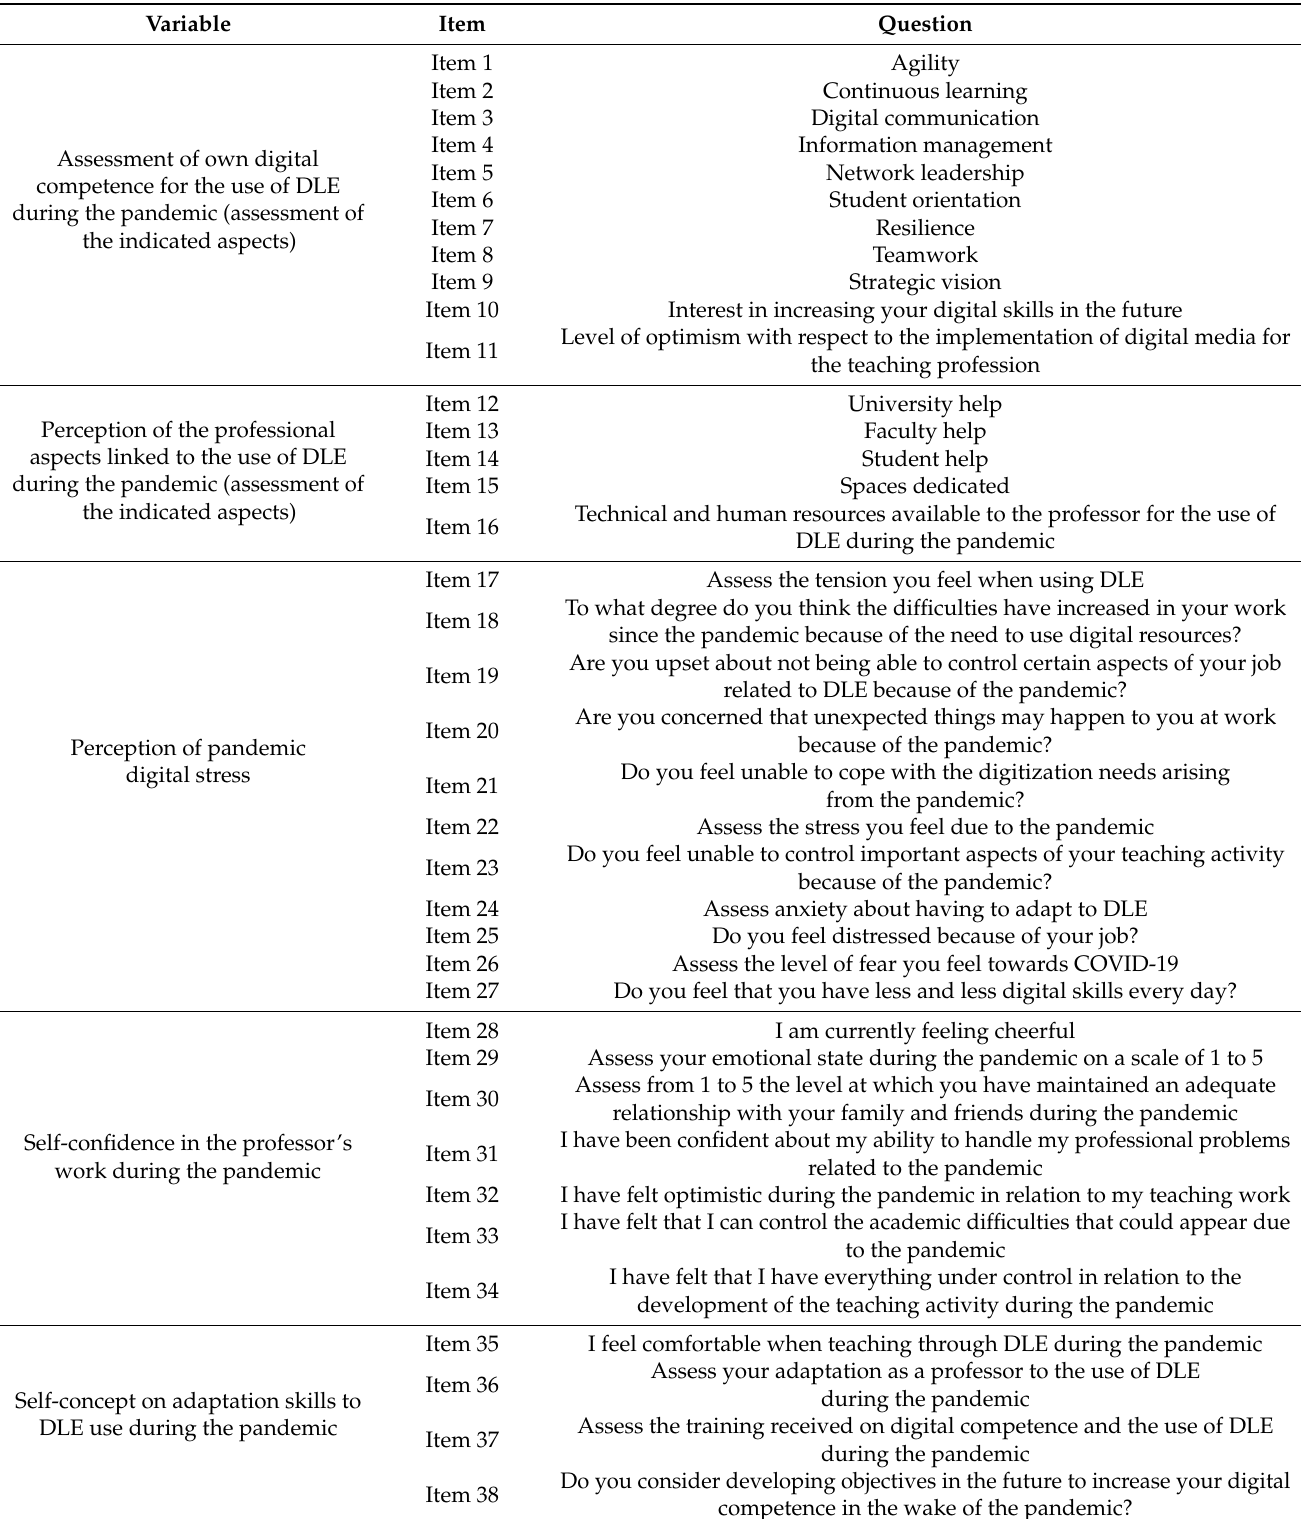
Table 1. Questions of the